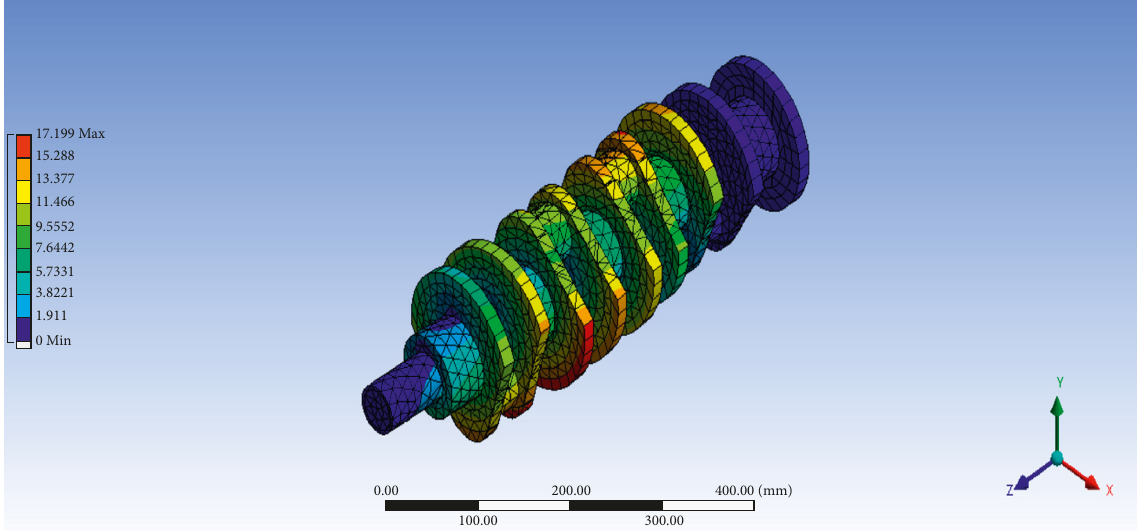
Figure 18: Deformation of FGM crankshaft at the second mode of vibration.